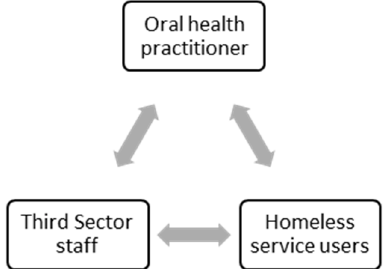
Figure 1. The Smile4life triadic working alliance.